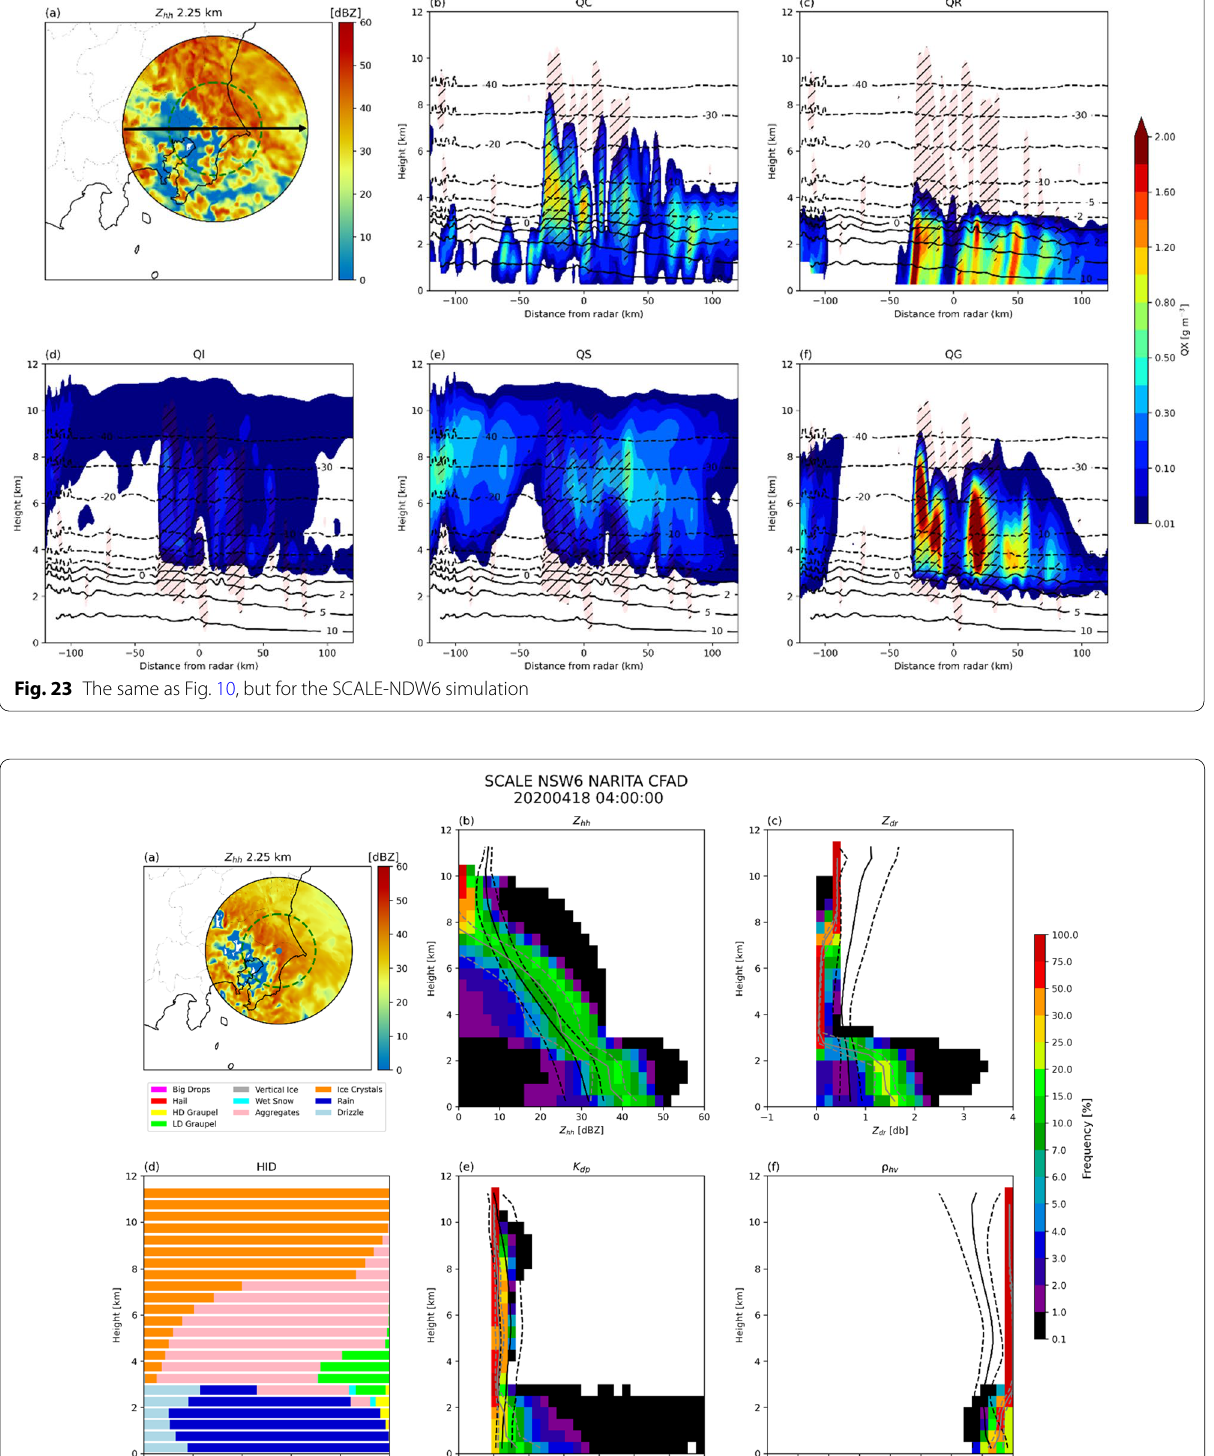
Fig. 24 The same as Fig. 15, but for the SCALE-NSW6